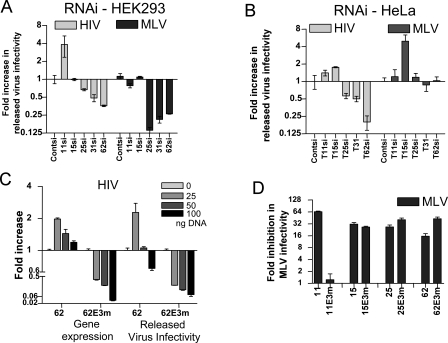
Inhibitory and Enhancing Roles of Individual TRIM Proteins on Viral Release(A, B) Fold increase in HIV and MLV infectivity released from HEK293 (A) and HeLa (B) cells treated with control siRNA (contsi) or siRNA targeting endogenously expressed human TRIM proteins 11, 15, 25, 31, and 62.(C) Fold increase in HIV gene expression and released infectivity in HEK293 cells transfected with increasing amounts of plasmid (0–100 ng) expressing TRIM62 or its E3 mutant (62E3m).(D) Infectivity of MLV released from HEK293 cells is shown as fold inhibition in presence of plasmids expressing TRIM11, 15, 25, 62, or their E3 mutants (E3m).